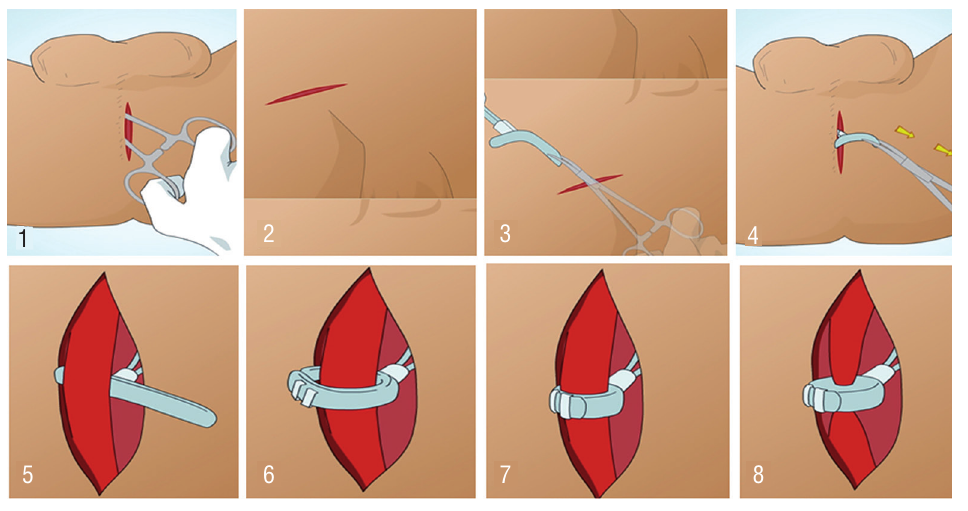
Figure 3 - Surgical technique and device implantation steps: 1-2) Perineal and inguinal incision, respectively; 3) Inguinal tunnel construction and device passage; 4) Device in the perineal region; 5-8) Periurethral cuff being activated and